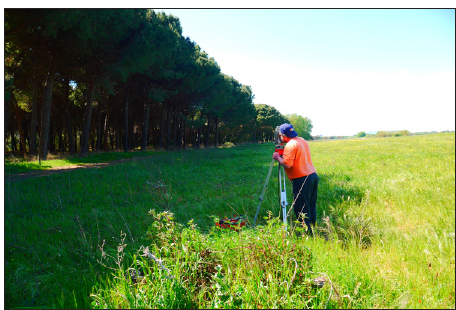
Figure 9: Preparing the grid for geophysics at the maritime port of Regae-Regisvilla, Italy (Photo Corinna